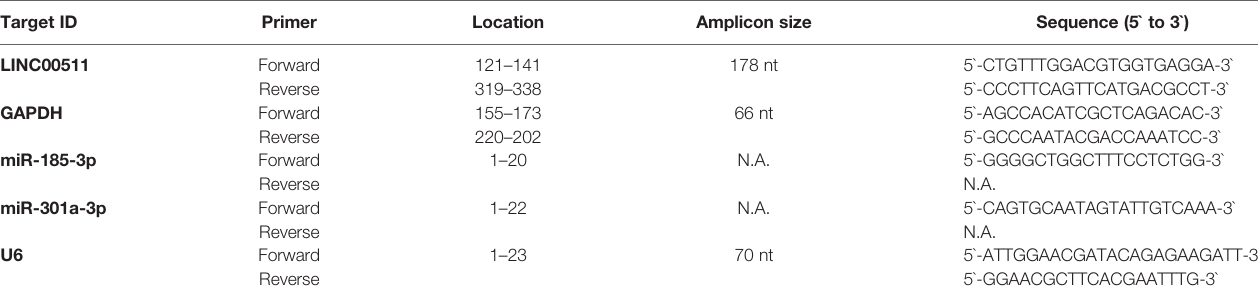
TABLE 1A | LINC00511, miR-185-3p, and miR-301a-3p primer sequences used for qPCR versus GAPDH and U6, respectively. Target